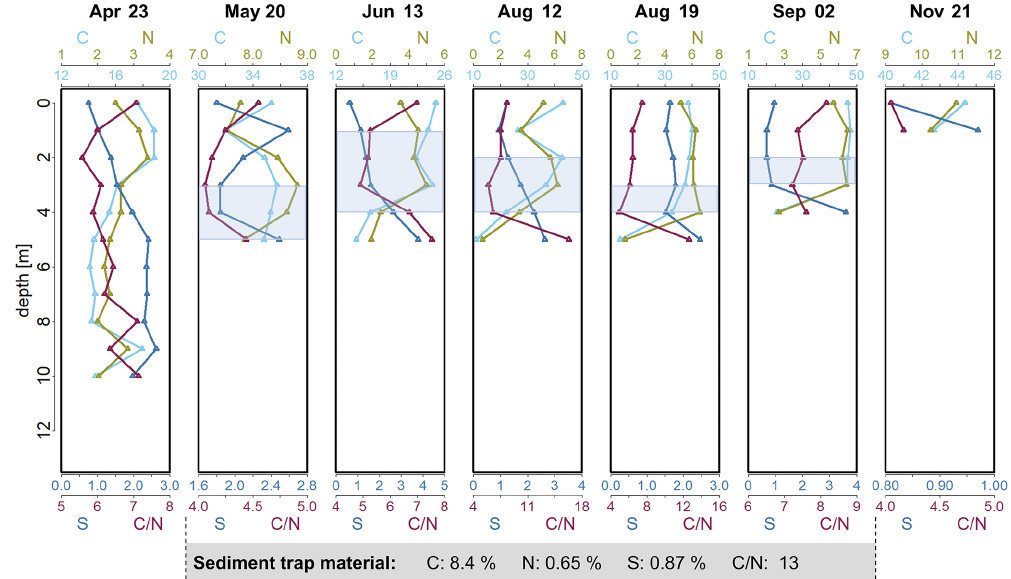
Figure 2. Depth profiles of C (%), N (%) and S (%) concentrations and calculated C / N ratio in the seston in Lake Ölper from April to November 2019. The depth of the sharp decrease in O 2 concentration and the start of Mn reduction (RTZ) are shown in each panel (shaded light blue). Concentrations of C (%), N (%) and S (%) and the C / N ratio of the sediment trap material collected during the 141d between 6 May and 24 September are given in the gray box below. Note that each column has an individual scale to better illustrate changes with depth. Depth profiles with the same scale in all columns are shown in the Supplement (Fig.